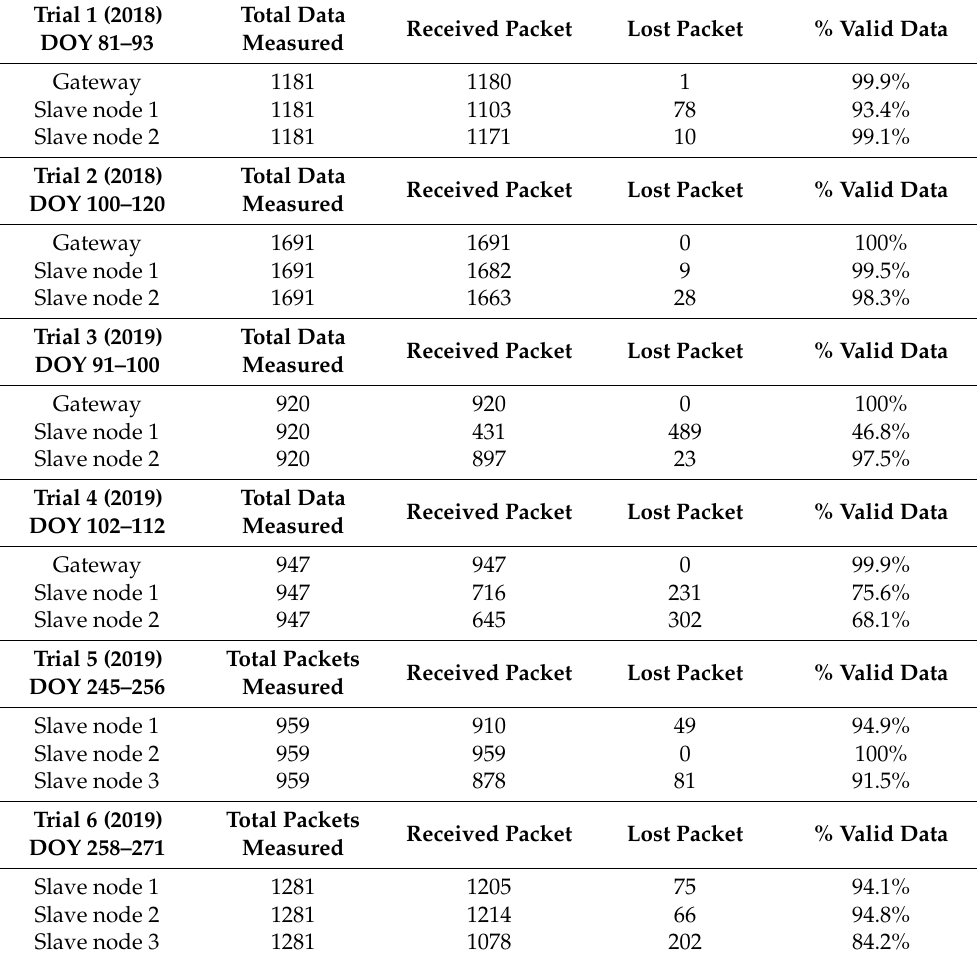
Table 2. Data communication results for performance